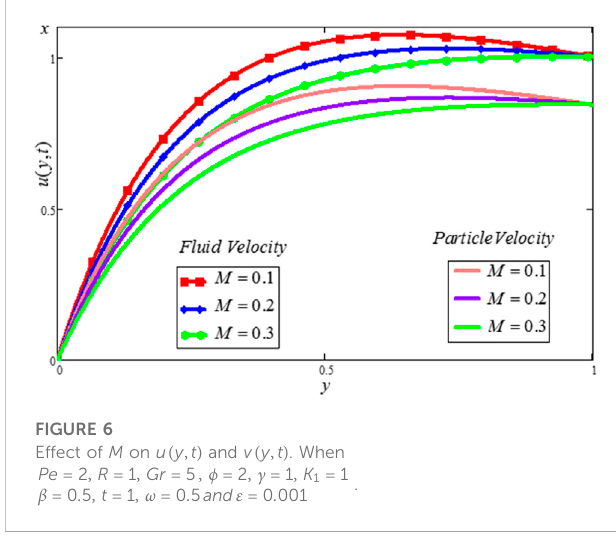
FIGURE 5 Effect of γ on u ( y , t ) and v ( y , t ) . When Pe (cid:2) 2 , R (cid:2) 1 , Gr (cid:2) 5 , γ (cid:2) 1 , M (cid:2) 0 . 5 , K β (cid:2) 0 . 5 , t (cid:2) 1 , ω (cid:2) 0 . 5 and ε (cid:2) 0 . 001 .